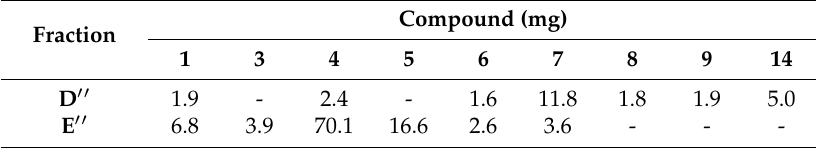
Table 2. Amounts of compounds isolated from the most active fractions of the acetone extract.